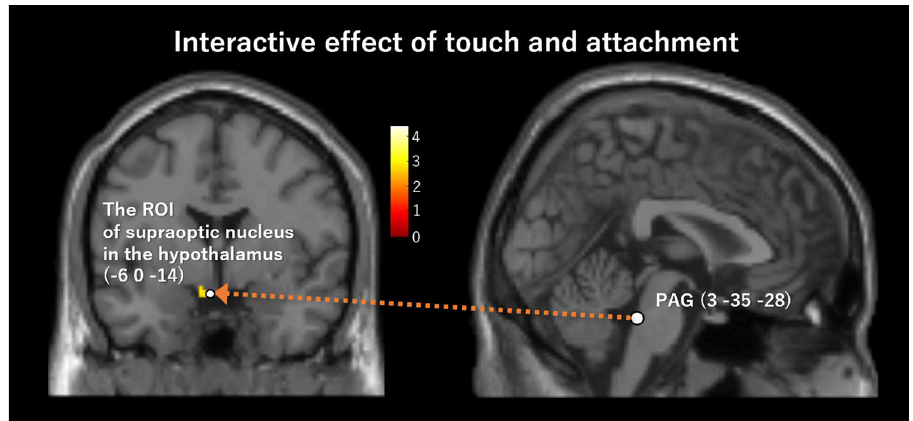
Figure 6. The right PAG (3, − 35, − 28) showed a positive connectivity with the ROI of right supraoptic nucleus in the hypothalamus (− 6, 0, − 14) in the interactive effect of touch and